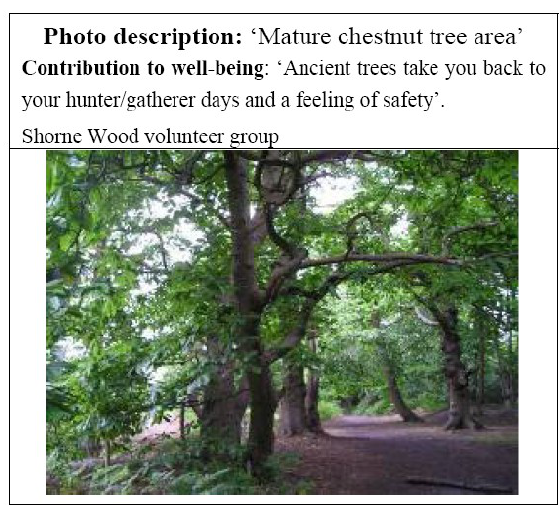
Figure 3. Feelings of